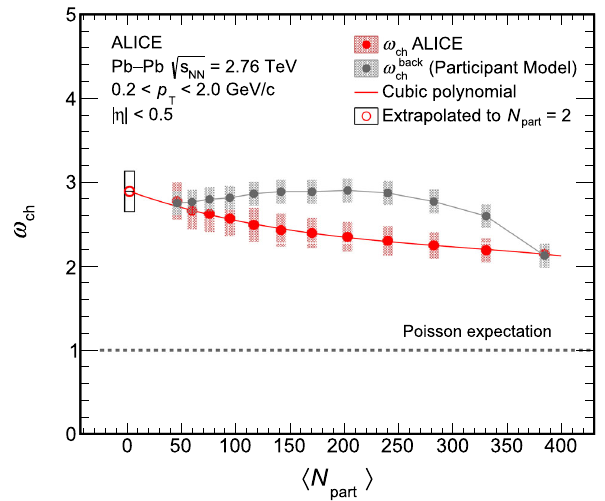
Fig. 4 Scaled variance as a function of (cid:3) N part (cid:4) for charged-particle multiplicity distributions and background fluctuations ( ω back a participant model calculation for | η | < 0 . 5. The expectation from Poisson-like particle production is indicated by the dotted line. The statistical uncertainties are smaller than the size of the markers. The systematic uncertainties are presented as filled